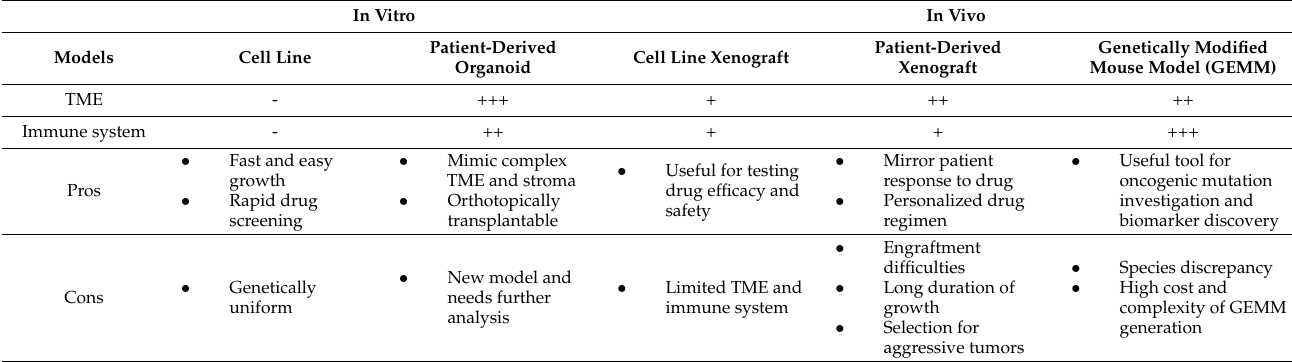
Table 1. Various models of pancreatic cancer for preclinical studies.